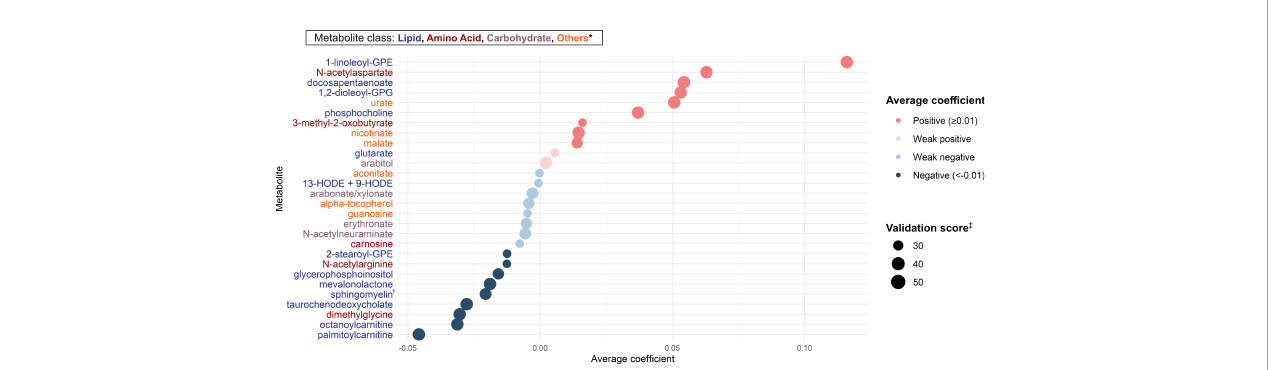
FIGURE 2 Metabolites selection for the mtQTL analyses By applying the Lasso regression models on nasopharyngeal metabolome (283 metabolites) data and the asthma outcome data of 744 infants hospitalized for bronchiolitis, we identi fi ed 28 candidate metabolites for the downstream mtQTL analyses. The average coef fi cient indicates the magnitude of the metabolite-outcome association averaged over times selected as a feature in 100 Lasso regression model executions. * Of 28 metabolites, 13 were lipids, 5 were amino acids, 4 were carbohydrates, and 6 were other classes (e.g., vitamins, nucleic acids) of metabolites. † Sphingomyelin (d17:1/16:0, d18:1/15:0, d16:1/17:0) ‡ The number of times selected as a feature of the Lasso regression model in 100 model executions. Abbreviations: GPE, glycerophosphorylethanolamine; GPG, glycero-3-phosphoglycerol; HODE, hydroxyoctadecadienoic acid.